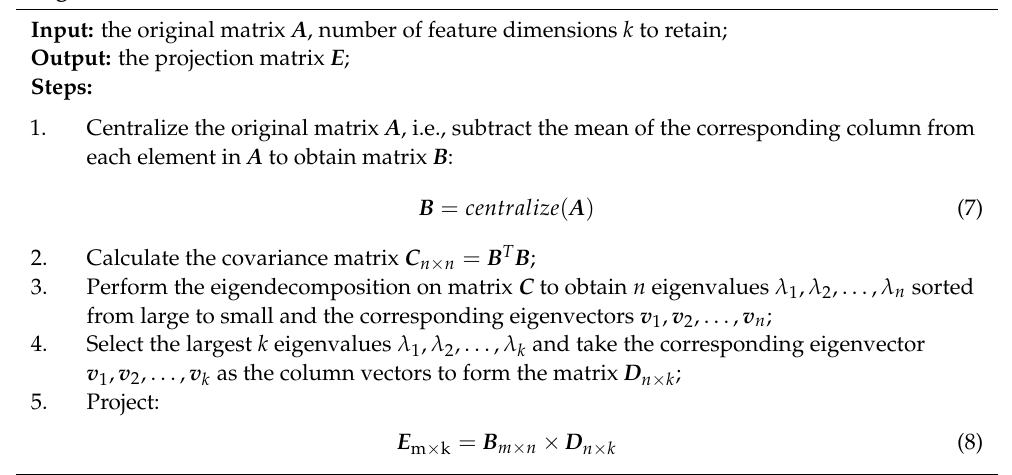
Algorithm 1 PCA